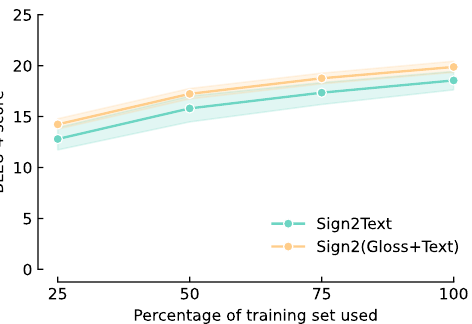
Figure 6. Zooming in on the development set curves of Figure 5, we observe that Sign2(Gloss+Text) models outperform Sign2Text models on average, and that they have lower variance. The slopes, however, are